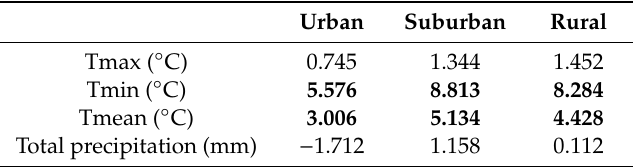
Table 1. t-test (t b values) for testing the significance of the slope of trend lines.